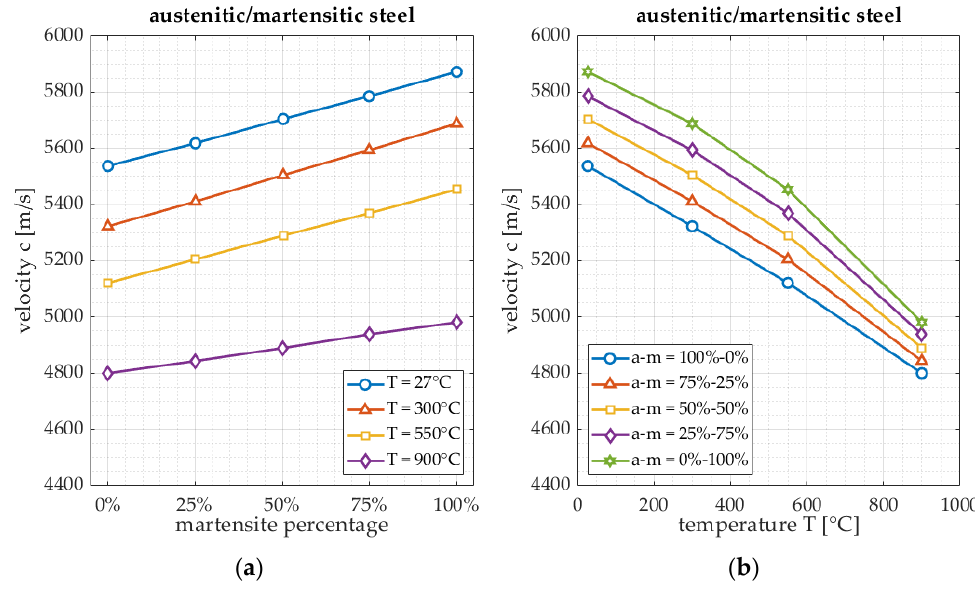
Figure 17. ( a ) The wave velocity as function of the phase ratio, and ( b ) as function of temperature.